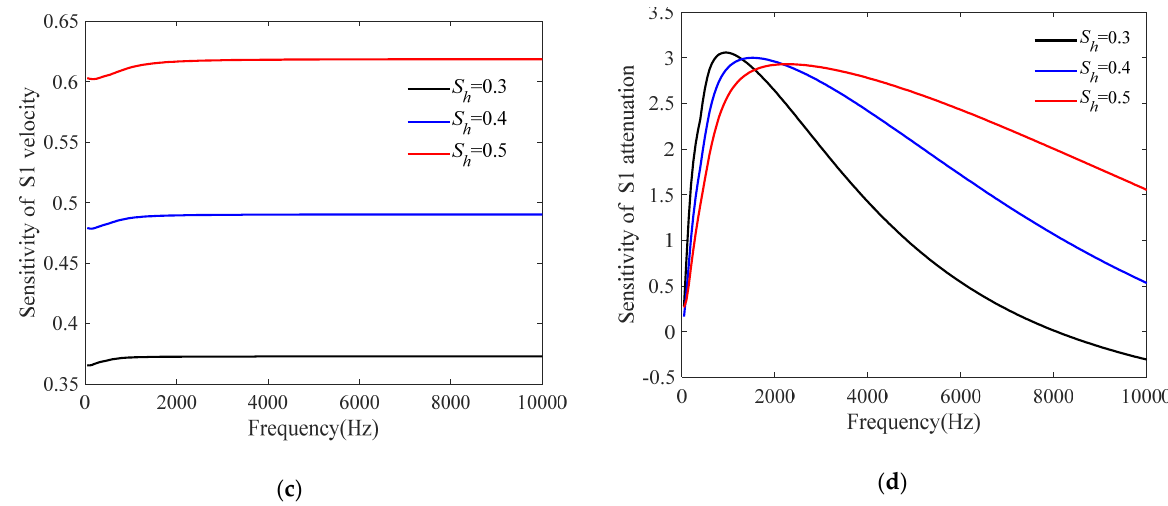
Figure 3. The sensitivities of velocities and attenuations of P1 and S1 to hydrate saturation. Gas hydrate saturation of 0.3, 0.4 and 0.5 and porosity of 0.5 are considered: ( a ) P1 velocity; ( b ) P1 attenuation; ( c ) S1 velocity; ( d ) S1 attenuation.